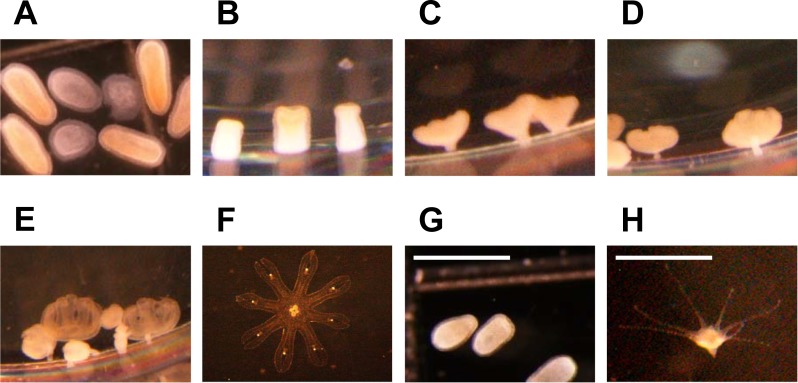
Two types of ontogenetic development of planulae in Maizuru Bay.Transformation process of the direct-development type from planula (A) to ephyra (F). The images B–F were taken 2, 6, 10, 12, and 15 days after the onset of incubation at 10°C, respectively. Transformation process of the metagenetic type from planula (G) to polyp (H). The image H was taken 7 days after the onset of incubation at 28°C. In B–E and H, A. coerulea attached to the wall of 24-well plates located in the lower part of the pictures. The scale bars indicate 1 mm.